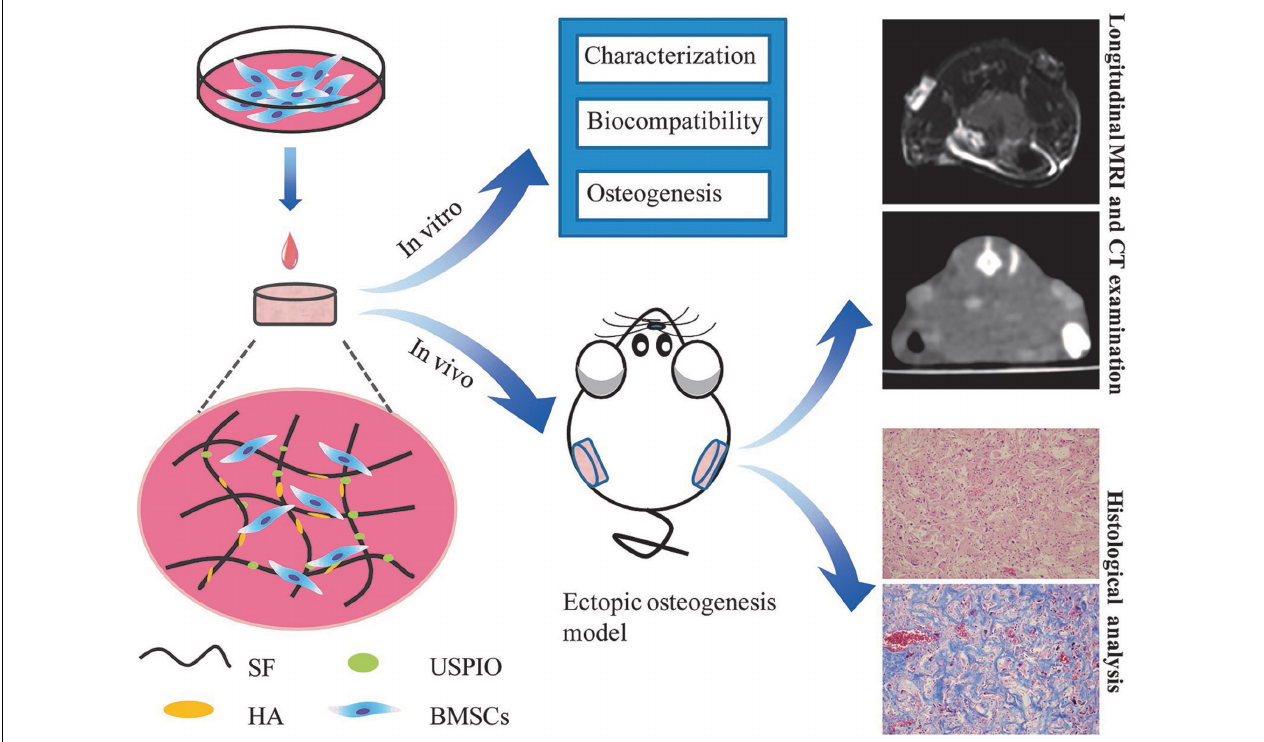
FIGURE 1 | Design of the USPIO-labeled SF/HA multifunctional scaffold system for in vitro and in vivo